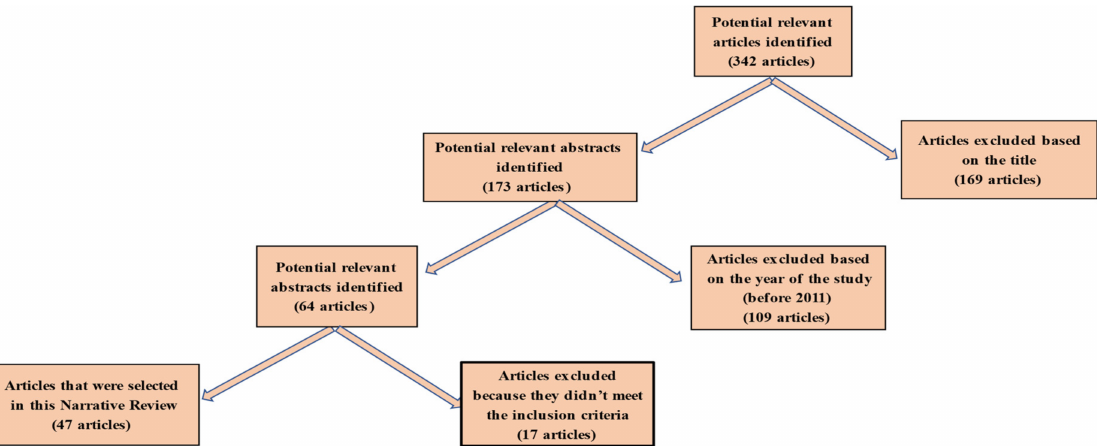
Figure 1. Flow diagram of the search